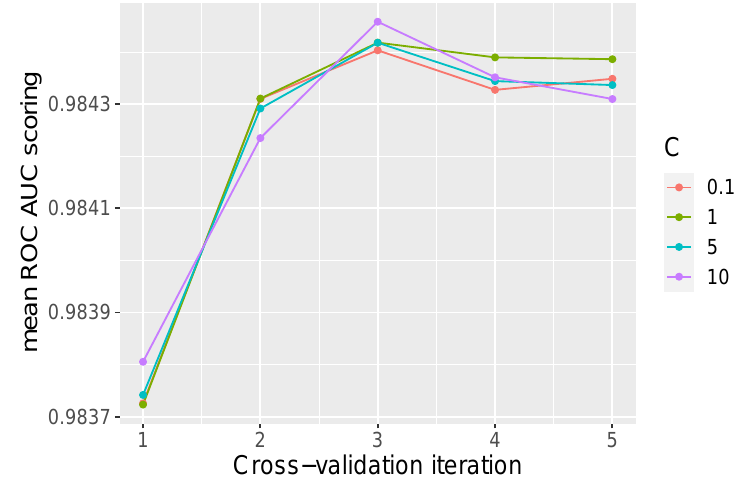
Figure 7. Support vector machine mean score by